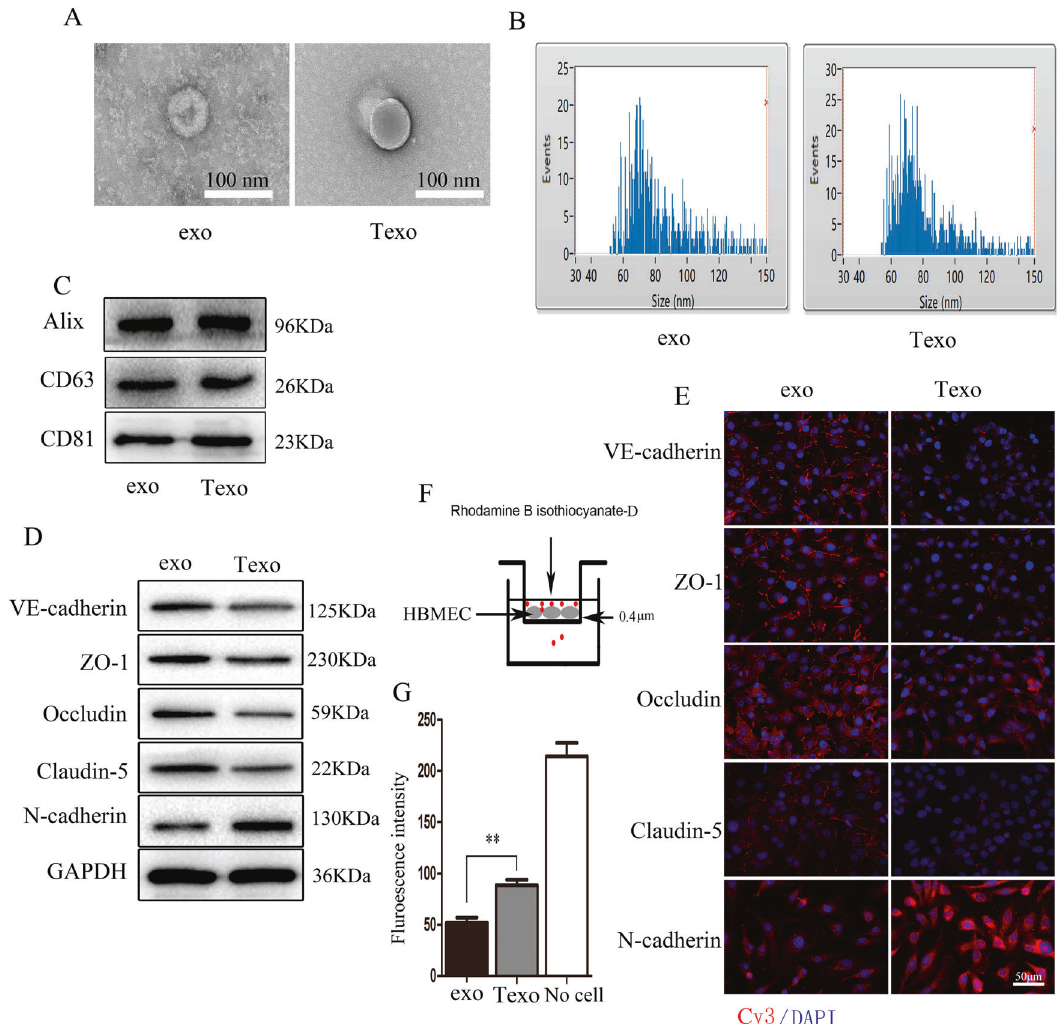
Fig. 1 TGF- β 1-mediated A549-derived exosomes promote EndoMT, downregulate the expression of tight junction proteins, and increase HBMECs monolayer permeability. A TEM images of exosomes secreted by A549 cells (exo) and of TGF- β 1-pretreated (10 ng/ml, 24 h) A549 cells (Texo). B The size distribution and concentration of exosomes are assessed by nanoparticle tracking analysis (NTA). C The expression of exosomes characteristic proteins Alix, CD81, and CD63 are detected using western blotting. D , E Expression of EndoMT markers (VE-cadherin, N-cadherin) and tight junction proteins (ZO-1, occludin, and claudin-5) in exo- and Texo-treated HBMECs as measured using IF (scale bar, 50 μ m) and western blotting assays. F Schematic representation of the Transwell chamber used for assaying transport across an endothelial monolayer. G The permeability of HBMECs (exo or Texo pre-cocultured) monolayer grown on 0.4- μ m fi lters as measured according to the appearance of rhodamine B isothiocyanate-dextran, which was added in the upper well at the beginning of the experiment and in the bottom well after 2-h incubation. ** p <